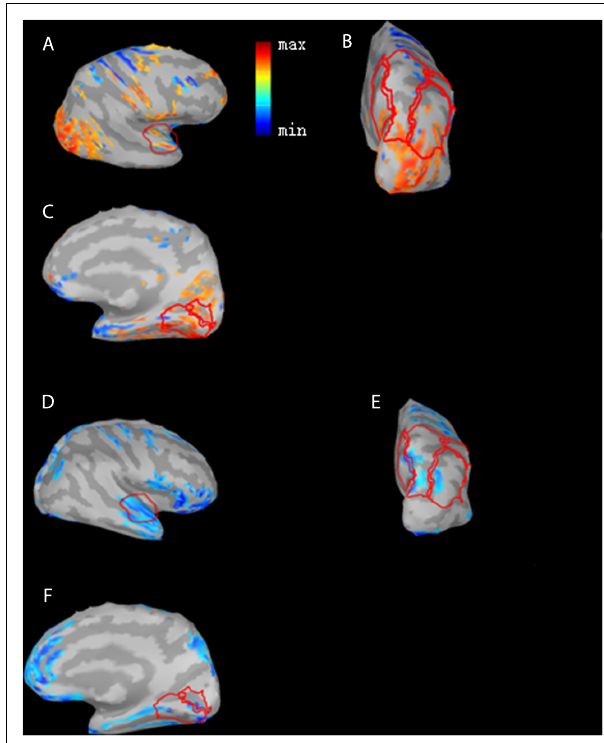
FIGURE 4 | Differences in N1 cortical responses between GCP and PCP at 0 month (0M) and the 12th month (12M). Red color indicates GCP > PCP (PAC (A) , PLC (B) , and PVC (C) ) at 0M while blue indicates PCP > GCP at 12M (PAC (D) , PLC (E) and PVC (F) ). The activation differences of the three ROI cortical regions, PAC (A) , PLC (B) , and PVC (C) , and GCP were significantly larger than PCP for the three ROIs ( p = 0.00538, t = 3.30 for PAC, p = 4.70e-06, t = 7.18 for PVC, and p = 0.0233, t = 2.55 for PLC) at 0M and descriptively smaller than PCP at